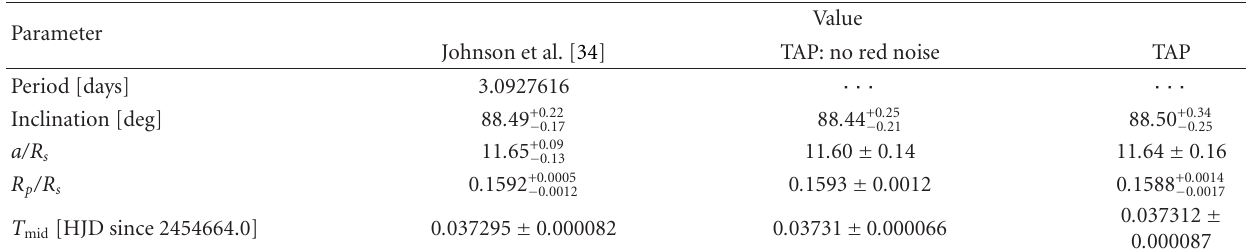
Table 1: Analysis of Johnson et al., [34] WASP-10b light curve.